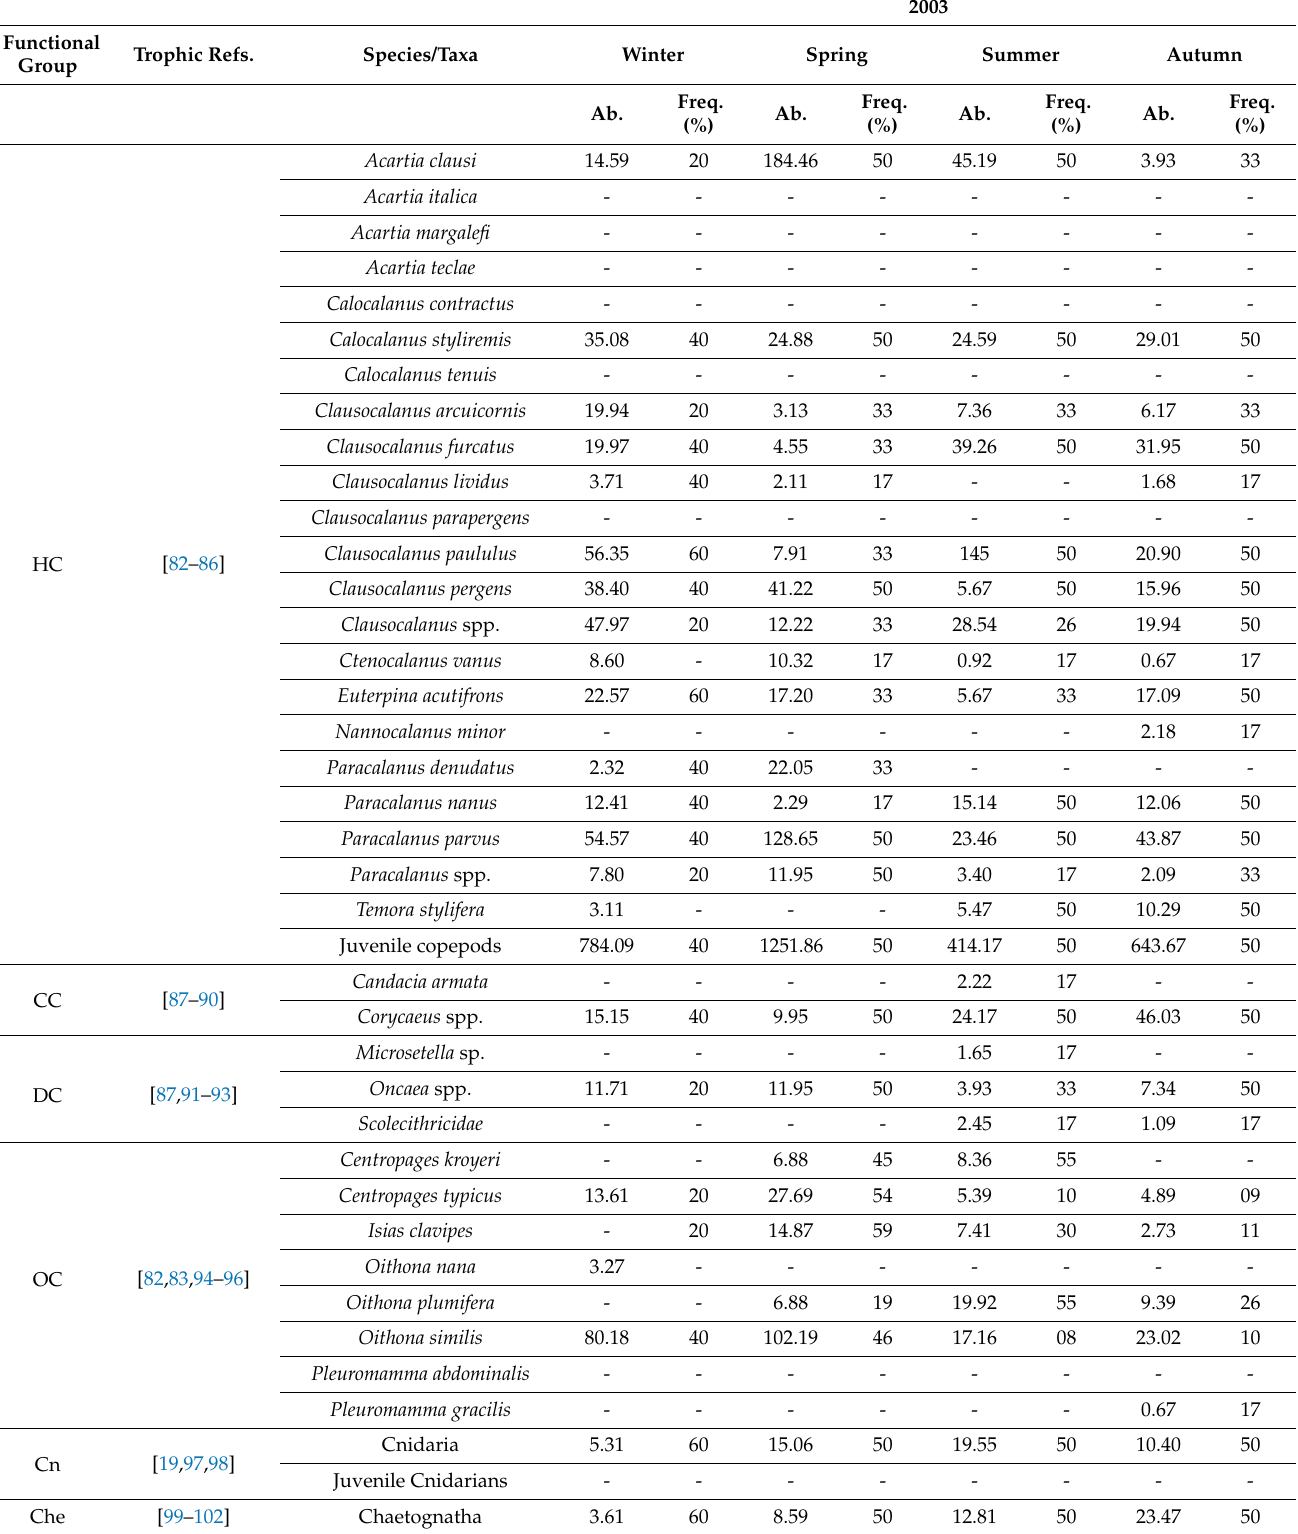
Table A3. Abundance and frequency of species in 2003 samplings.